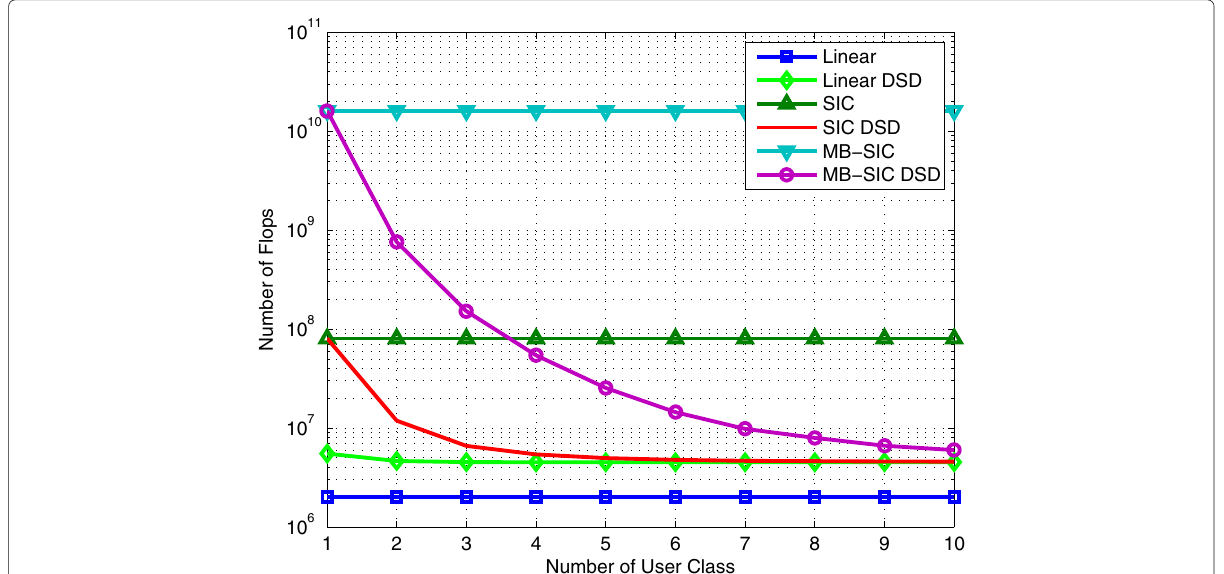
= 2 antennas per user, N = 200 receive r k , n